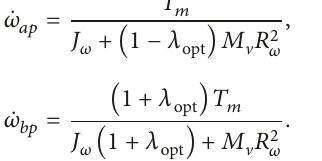
Figure 11: The relationship between the longitudinal friction coeffi- cient and the slip ratio.